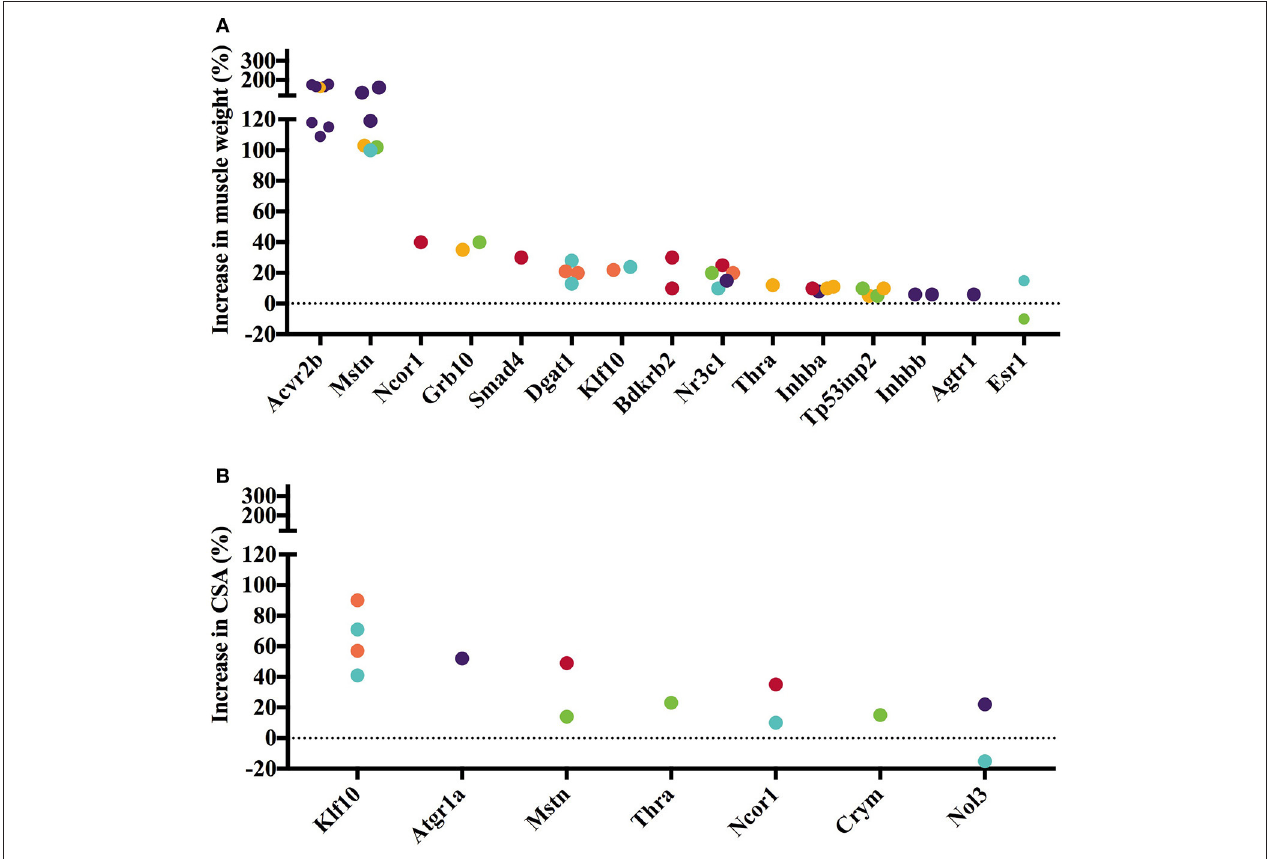
FIGURE 2 | Gene knock out or loss-of-function increases muscle weight and cross-sectional area (CSA). Increase in muscle weight (A) and fiber or muscle CSA (B) after gene knock out differs across genes and between muscles. Individual muscles are color-coded as follows: • Gastrocnemius, • Soleus, • Tibialis anterior, • Quadriceps, • Extensor digitorum longus, • Other. Data is based on values collected in Supplementary Table